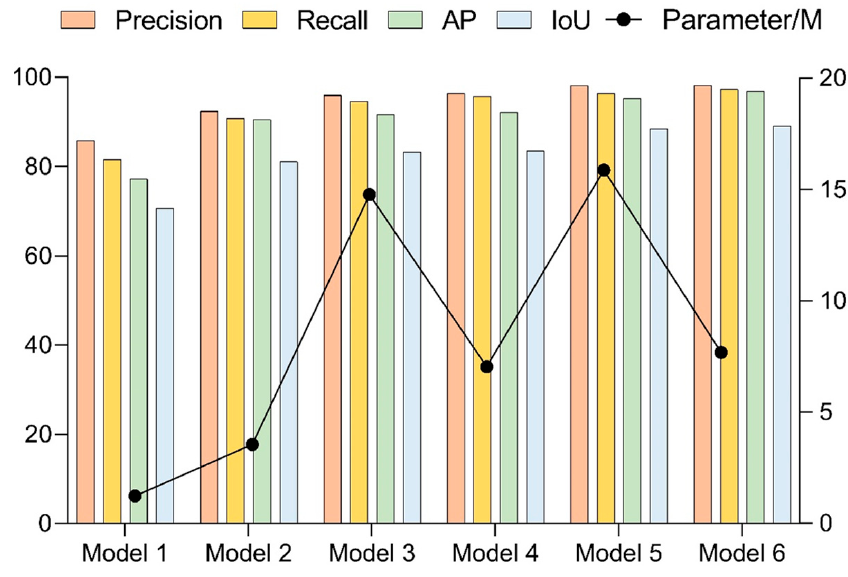
Figure 14. Comparative results of ablation experiments. Table 3. Comparative results of ablation experiments.